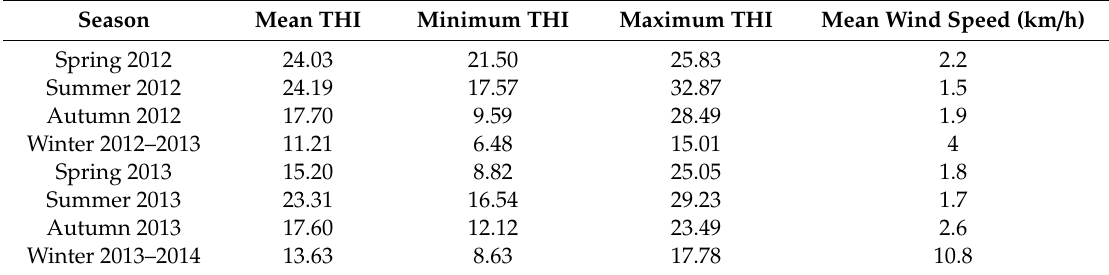
Table 3. Temperature-humidity index (THI) and mean wind speed for each season from 2012 until